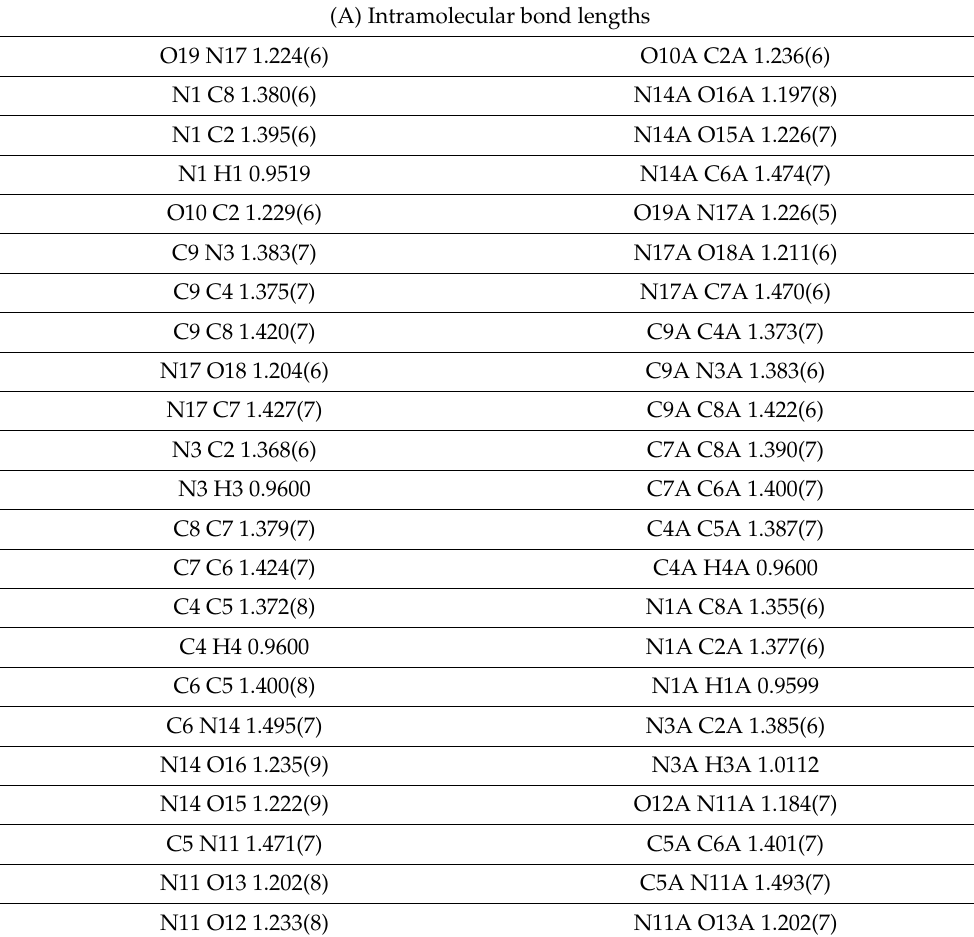
Table A1. Selected bond lenths (A) and angles (B) for the compound TriNBO obtained from X-ray diffraction data